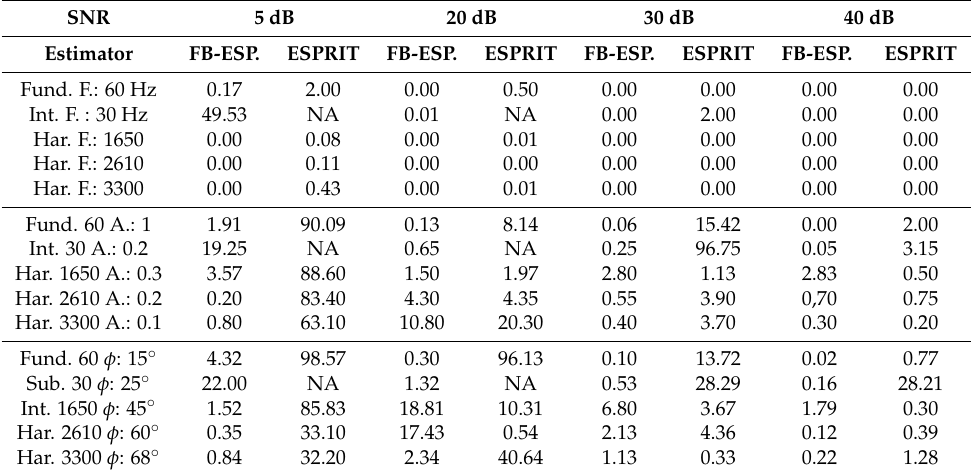
Table 5. Percent error (%) in signal s 1 ( t ) parameters’ estimation in 1000 runs by FB-ESPRIT and the conventional ESPRIT method at different SNR levels (5, 20, 30, 40 dB) under contamination of blue noise.